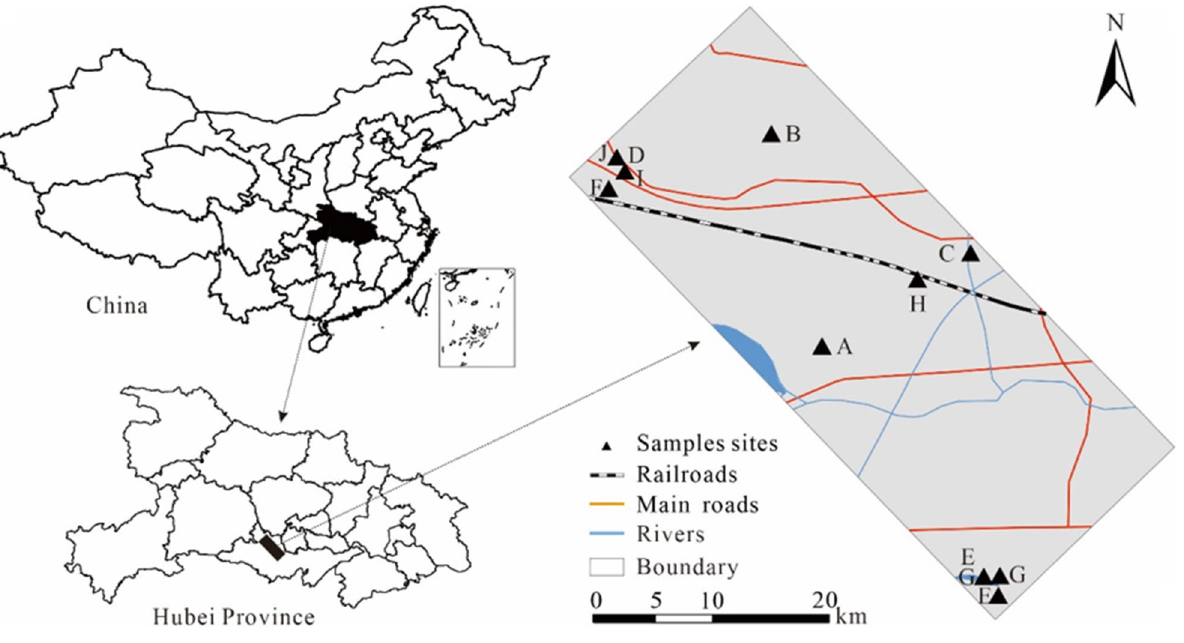
Figure 1. Sampling point map of the study